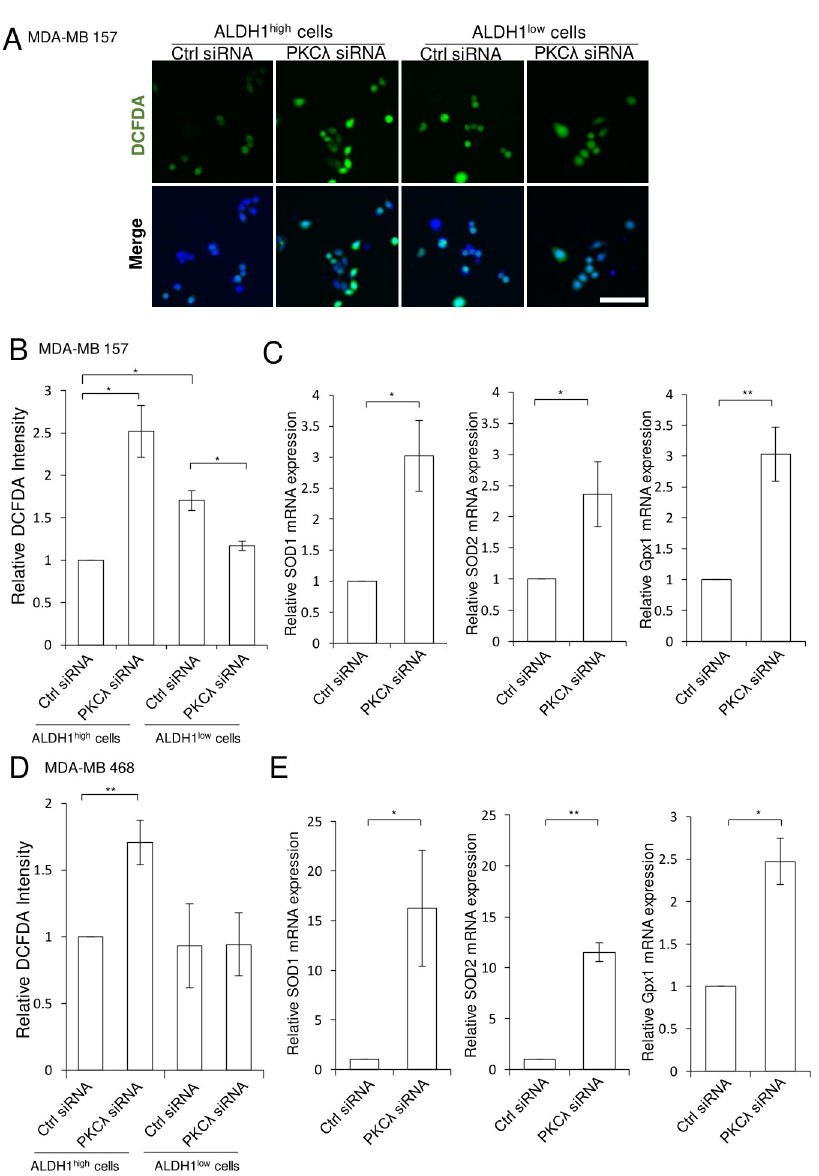
Fig 6. PKC λ depletion leads to increased intracellular ROS levels in ALDH1 high cells. (A) Representative images of DCFDA-positive cells in control KD and PKC λ KD of MDA-MB 157 ALDH1 high cells. Nuclei are stained with Hoechst 33342 (blue). (B) Intracellular ROS levels in ALDH1 high and ALDH1 low MDA-MB 157 after PKC λ siRNA transfection. � p < 0.05, Student’s t-test. Data depict the mean ± SD. (three independent experiments). (C) Quantitative PCR analysis of antioxidant genes (SOD1, SOD2 and Gpx1) 48 h after PKC λ siRNA transfection of ALDH1 high cells isolated from MDA-MB 157 cells. � p < 0.05, �� p < 0.01, Student’s t-test. Data depict the mean ± SE (three independent experiments). (D) Intracellular ROS levels in ALDH1 high and ALDH1 low MDA-MB 468 after PKC λ siRNA transfection. � p < 0.05, Student’s t-test. Data depict the mean ± SD. (four independent experiments). (E) Quantitative PCR analysis of antioxidant gene (SOD1, SOD2 and Gpx1) expression 48 h after PKC λ siRNA transfection of ALDH1 high cells isolated from MDA-MB 468 cells. � p < 0.05, �� p < 0.01, Student’s t-test. Data depict the mean ± SE (Three independent experiments). Scale bar; 100 μ